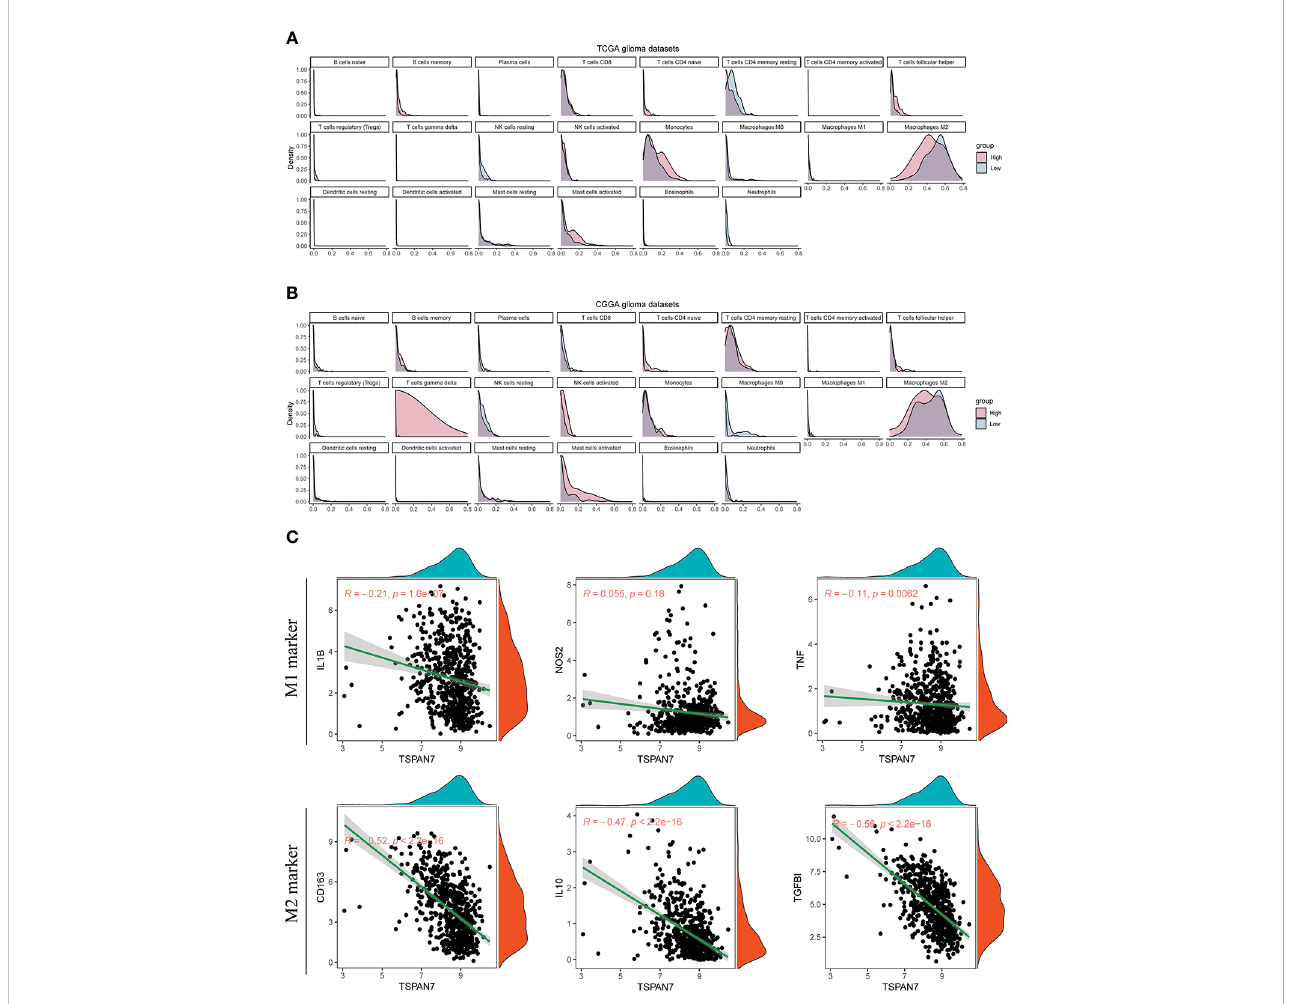
FIGURE 6 The relationships between TSPAN7 expression and immune in fi ltration of 22 immune cells in glioma immune microenvironment. (A, B) Relative immune cell in fi ltration level of 22 immune cells between TSPAN7 high expression and low expression subgroup in TCGA and CGGA datasets. (C) Correlation analysis of TSPAN7 with M1 type and M2 type macrophage related speci fi c markers in TCGA